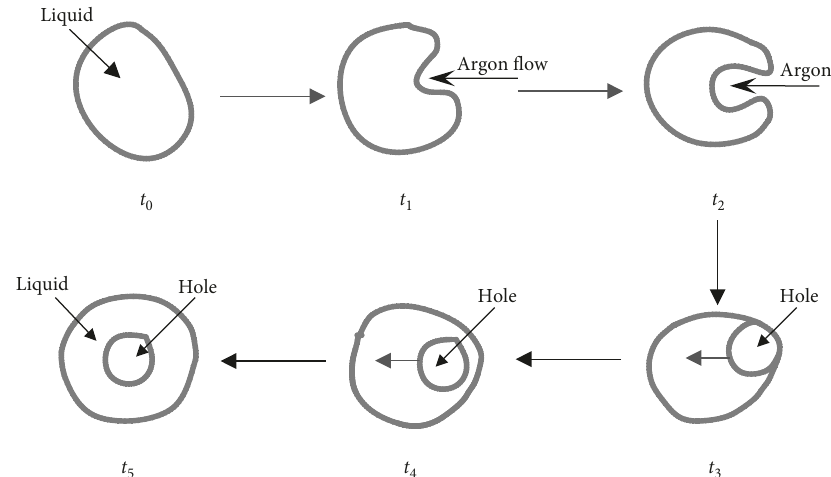
Figure 5: Schematic diagram of the formation of hollow particles. t dropped; t 1 ∼ t 2 : droplet surface deepened further; t 2 ∼ t 3 : gas entered into liquid under pressure; t 3 ∼ t 4 : the hole closed inside the droplet; t 4 ∼ t 5 : the hole migrated to the interior of droplet.